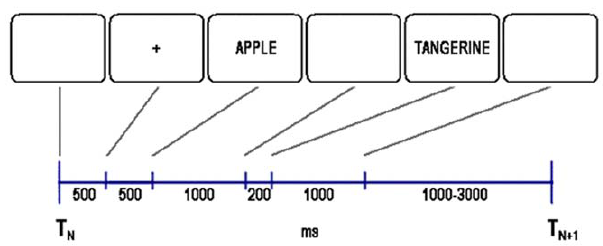
Figure 1. The time course for the evoked potential trial to the paired associates. T N is the beginning of the Nth trial and T N + 1 the beginning of the subsequent